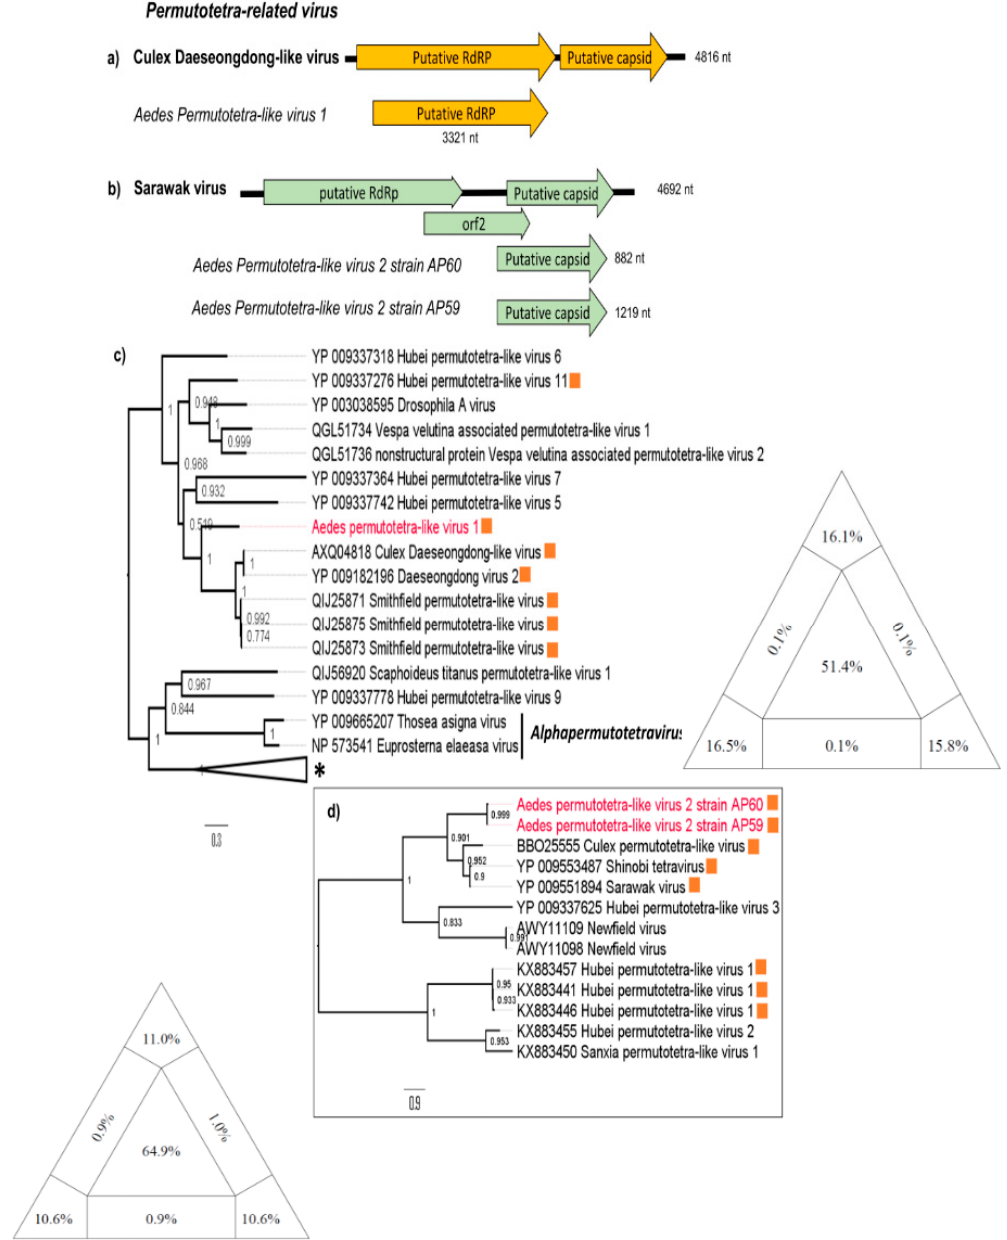
Figure 3. Permutotetra-related contigs position in most related viruses genomes. ( a ) Schematic representation of Culex Daeseongdong-like virus, Aedes permutetra-like virus 1 , ( b ) Sarawak virus and Aedes permutetra-like virus 2 . ( c ) Maximum likelihood phylogenetic tree for RdRp protein and ( d ) maximum likelihood phylogenetic tree for capsid protein. Viruses originally found in mosquitoes are marked by orange. Sequences from this study are indicated in red. * Indicate the location in the RdRp tree of the reference viruses used to construct the capsid tree. The diagram in the base of the tree is the likelihood map. The likelihood quartet mapping is a method that allows to visualize the tree-likeness of all quartets in a single graph and provide a direct measure of the phylogenetic signal in an alignment. The triangle shows the location of all quartets calculated with the alignment used to infer the ML tree. Values in the center of the triangle represent the percentage of unresolved quartet trees (star-like trees), values in the vertices represent the percentage of fully resolved trees and values in the intermediate areas (between vertices) are the percentage of conflicting trees. The analysis was performed using JTT + gamma correction model as is implemented in the tree puzzle software v 5.3 (http: //